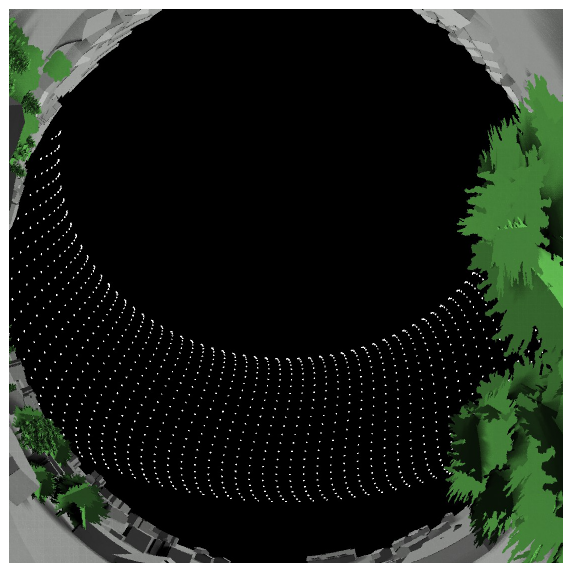
Figure 6. Fisheye view (hemispherical projection) of sunny sky model with 1280 timesteps as seen from the roof of the case study, with south in the lower